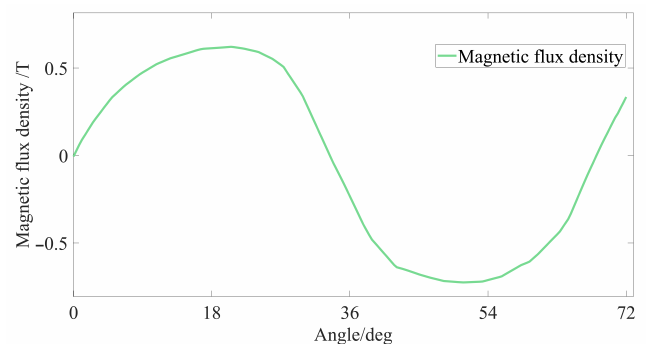
Figure 2. The air gap flux density waveform of the